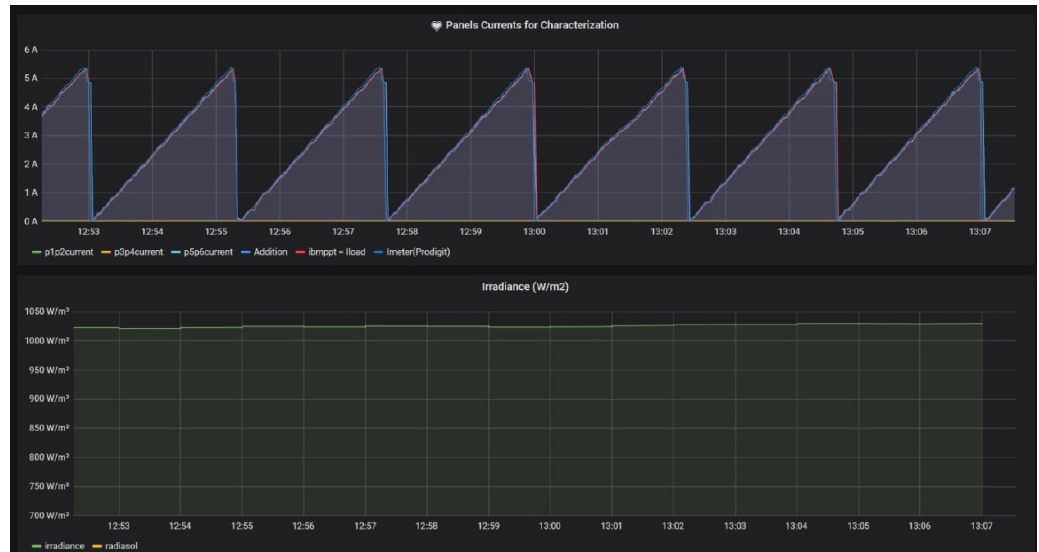
Figure 12. Detailed view of Grafana GUI to observe PV current and irradiance during characterization.